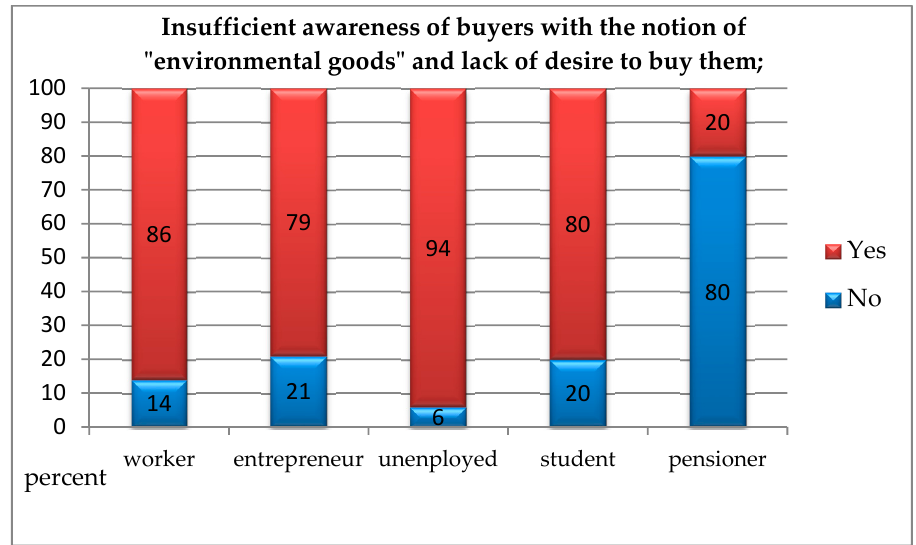
Figure 3. Insufficient awareness of consumers regarding the concept of “ecological goods” and the lack of willingness to purchase them as the current problem with the market for environmental goods according to people with a different social status.